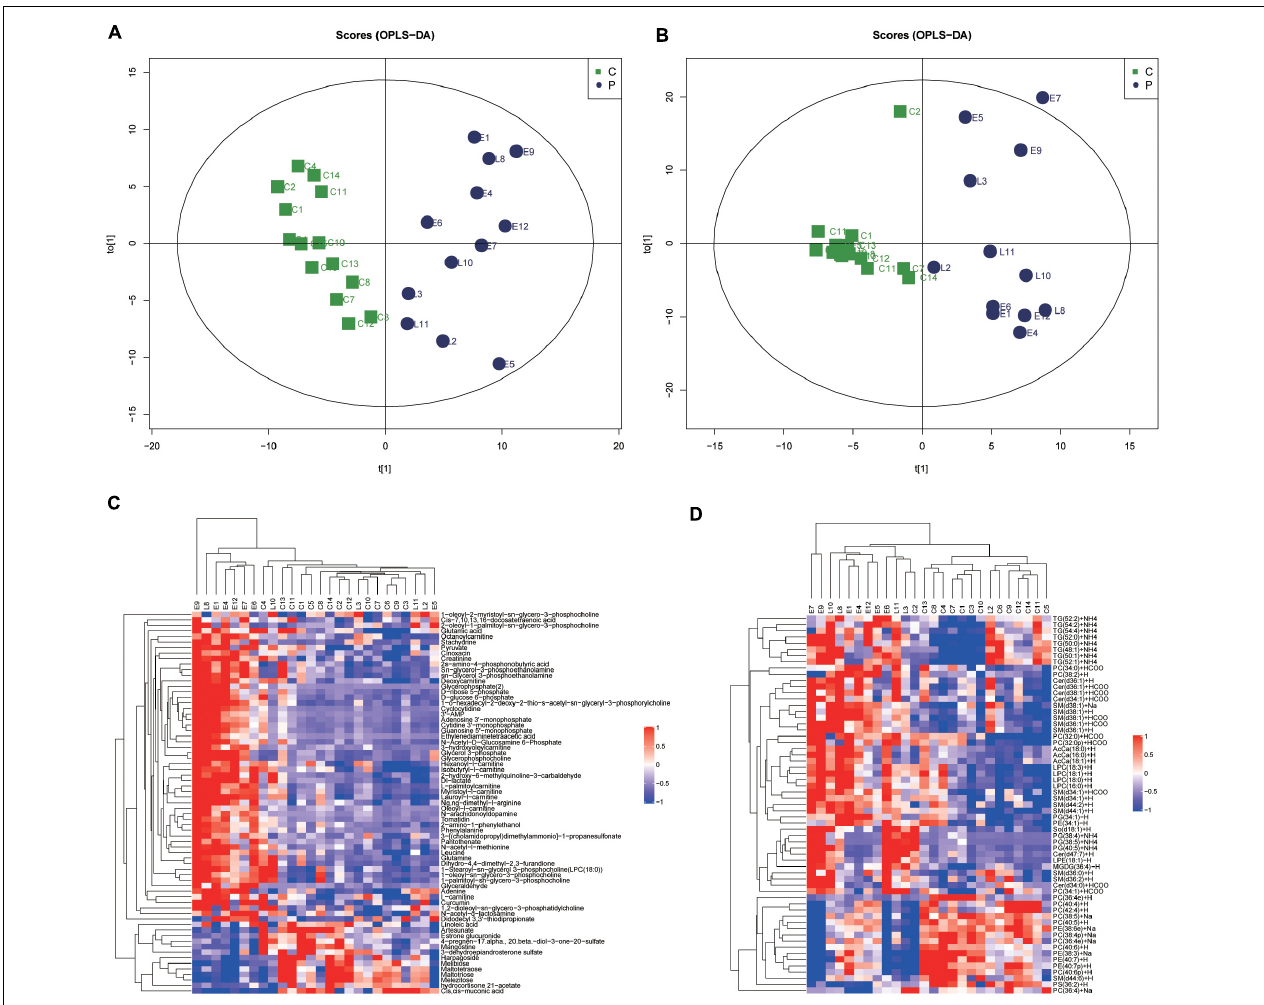
FIGURE 1 | Metabolic shifts in placentas of preeclampsia. (A,B) The score plot of the supervised orthogonal partial least squares discriminant analysis (OPLS-DA) of metabolomic (A) and lipidomic analysis (B) . Control (green) group, preeclampsia (blue) group. Model parameters: R 2 Y = 0.845, Q 2 = 0.351 in metabolomics analysis and R 2 Y = 0.848, Q 2 = 0.421 in lipidomics analysis. (C,D) Unsupervised hierarchical clustering analysis of placental metabolome (C) and lipid (D) profiles. Each row and column represent a metabolite and a case, respectively. The relative level of each metabolite is represented by a color, as shown in the right-side color